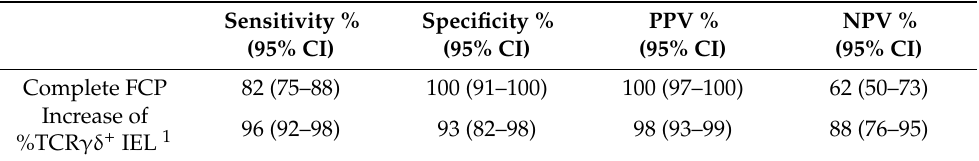
Table 6. Accuracy of the coeliac cytometric pattern for the diagnosis of coeliac disease. Control group subjects under 25% IEL ( n =